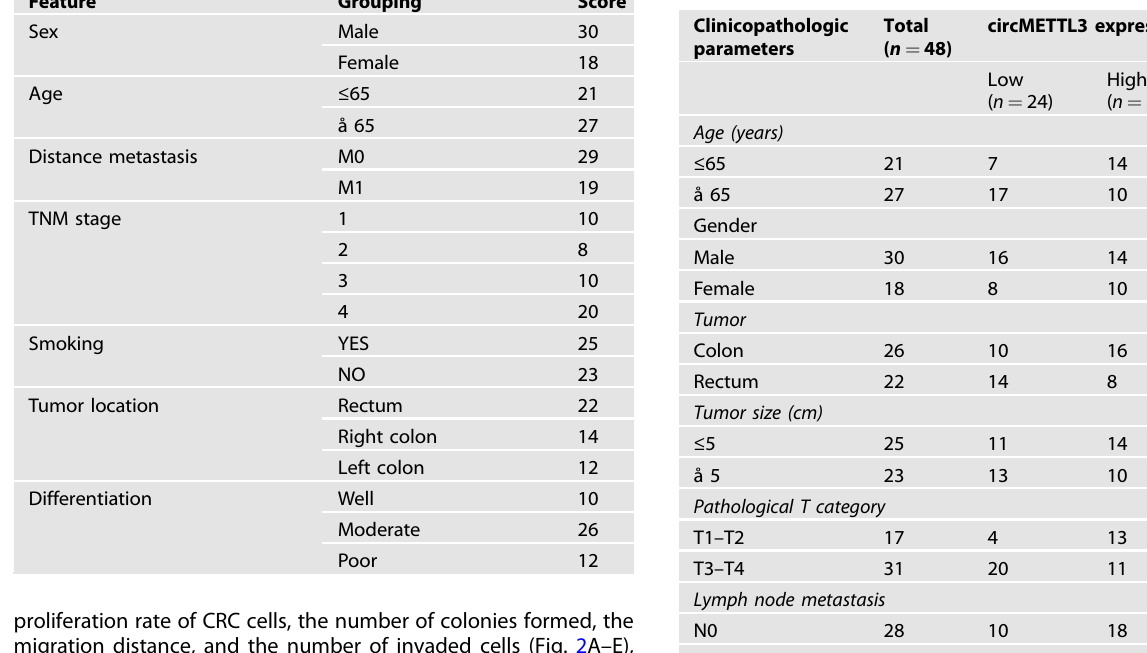
Table 2. Correlations between circMETTL3 expression and clinical characteristics in CRC patients ( n =